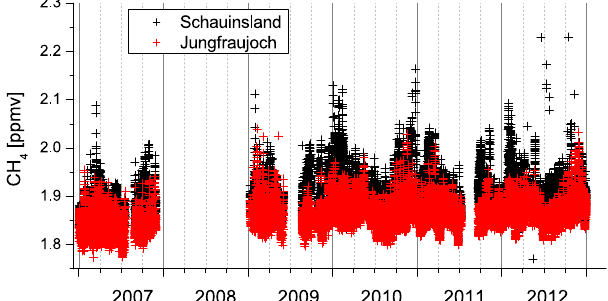
Figure A4. Example of Schauinsland and Jungfraujoch CH 4 in situ data for a period in November 2010. Upper panel: all data. Lower panel: data retained after applying the filter for common